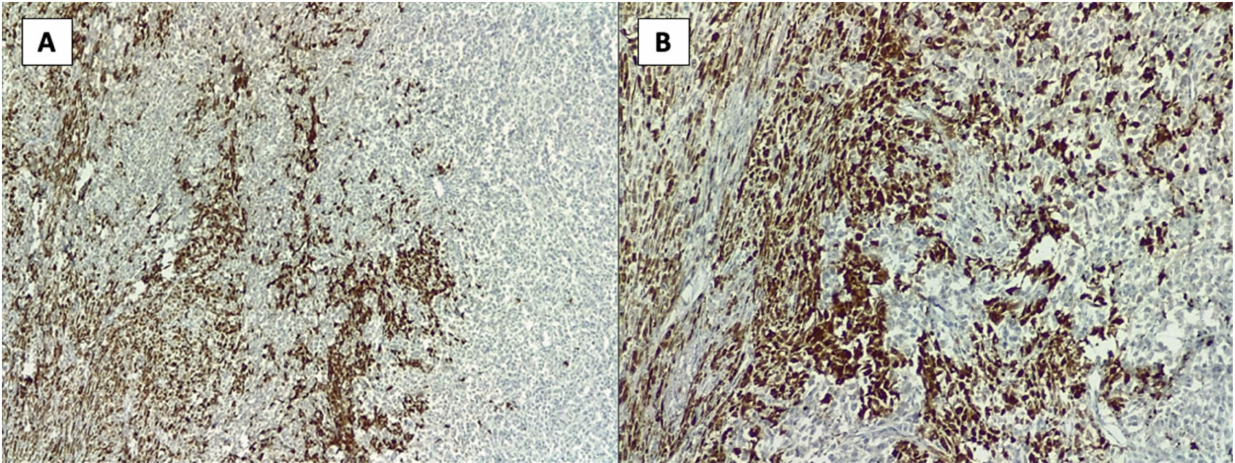
Figure 6. Immunohistochemistry images showing marker S100 positive for sternal chondrosarcoma: